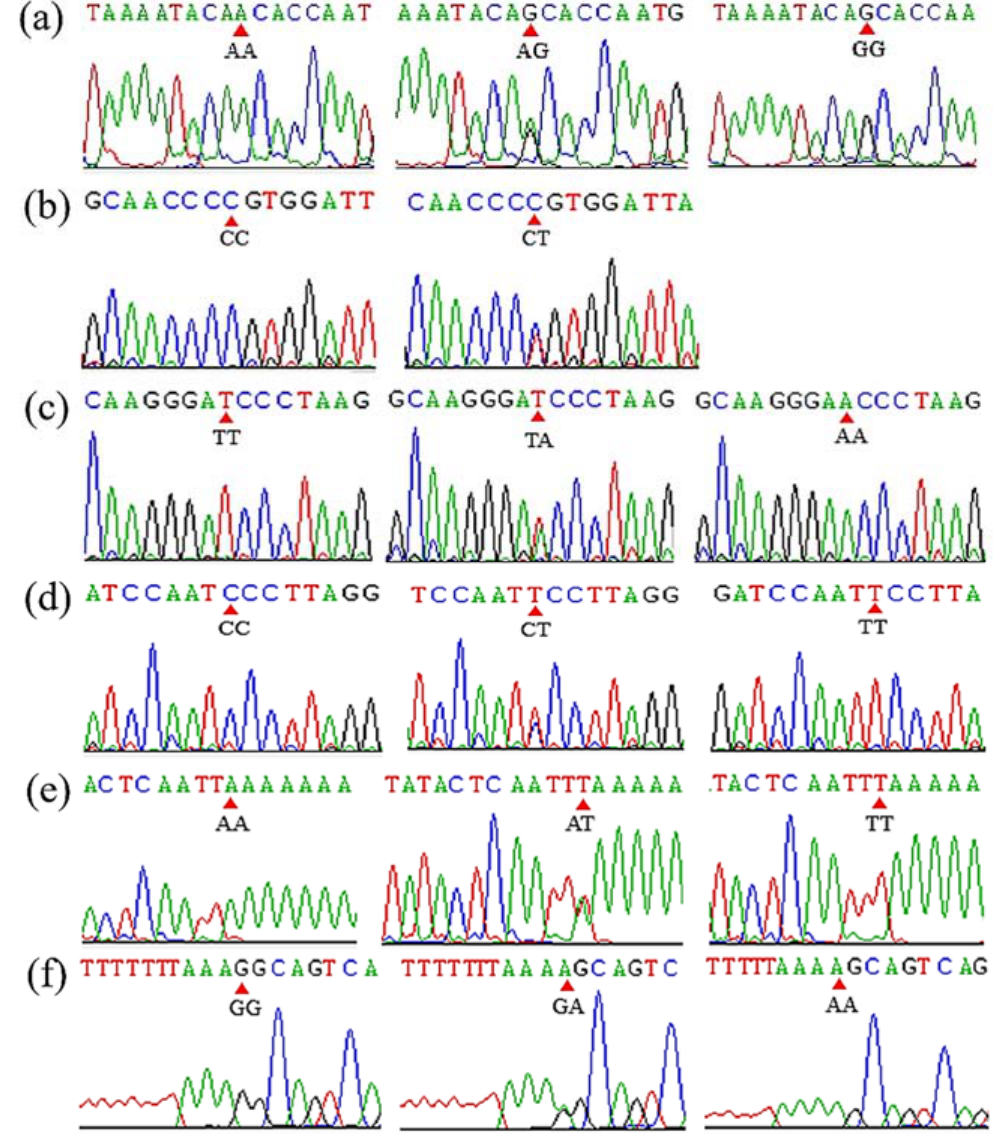
Figure 2. The result of sanger sequencing of SNP1 ( a ), SNP4 ( b ), SNP5 ( c ), SNP7 ( d ), SNP9 ( e ) and SNP10 ( f ) mutations in goat DNAH1 gene.